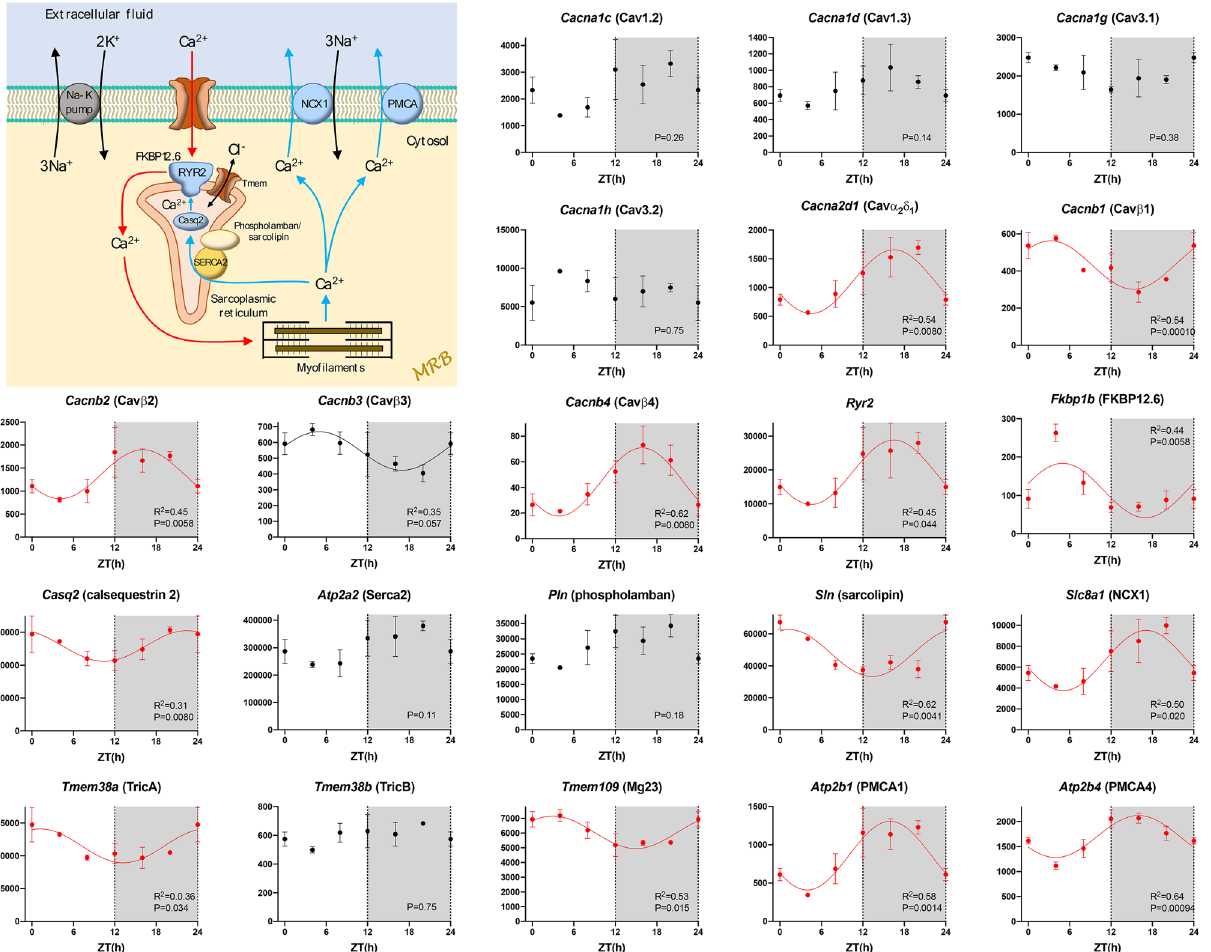
Figure 3. Ca 2+ clock pacemaker mechanism. Abundance (normalised counts) of Ca 2+ clock transcripts is shown over 24 h. The inset shows a schematic diagram of the Ca 2+ clock. See Fig. 1 legend for further